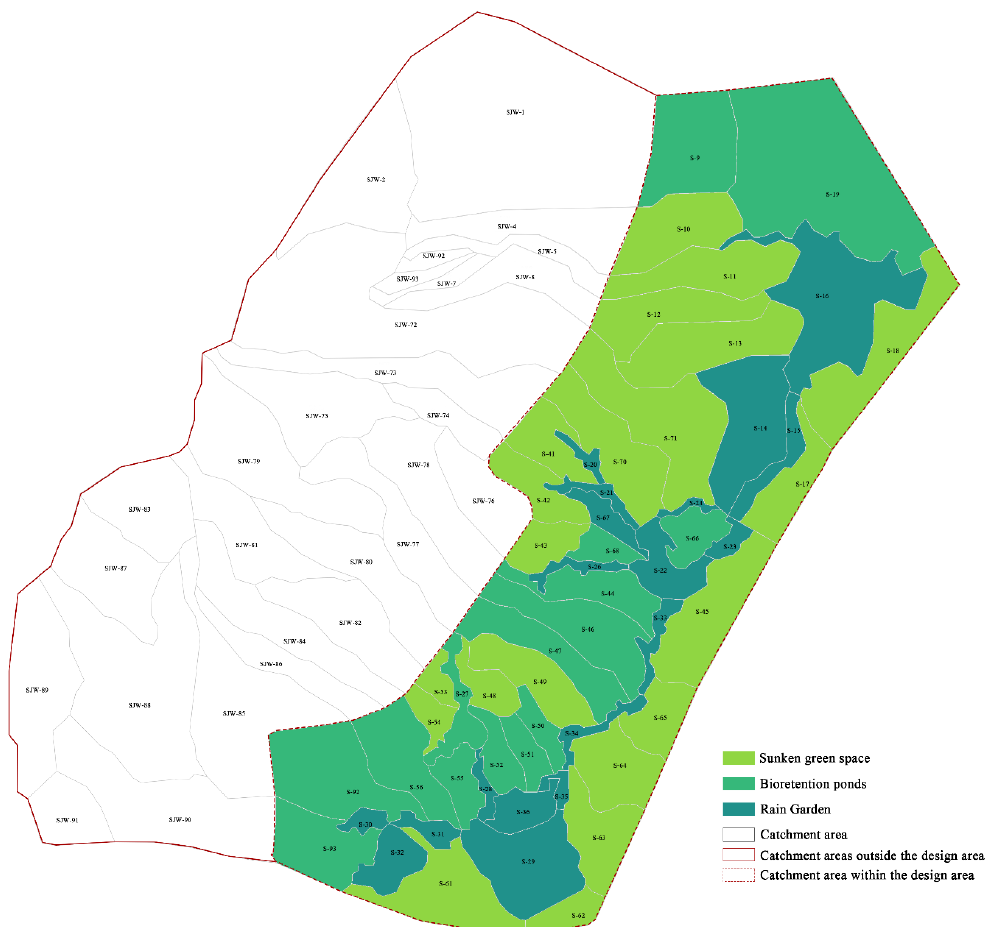
Figure 5. Initial scheme of the LID facility layout.